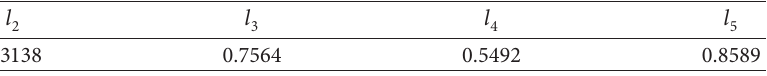
Table 3: Encryption key we